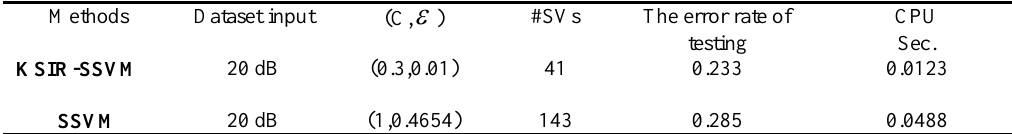
Table 2. Identification results of proposed scheme for conditions including internal fault and inrush current.